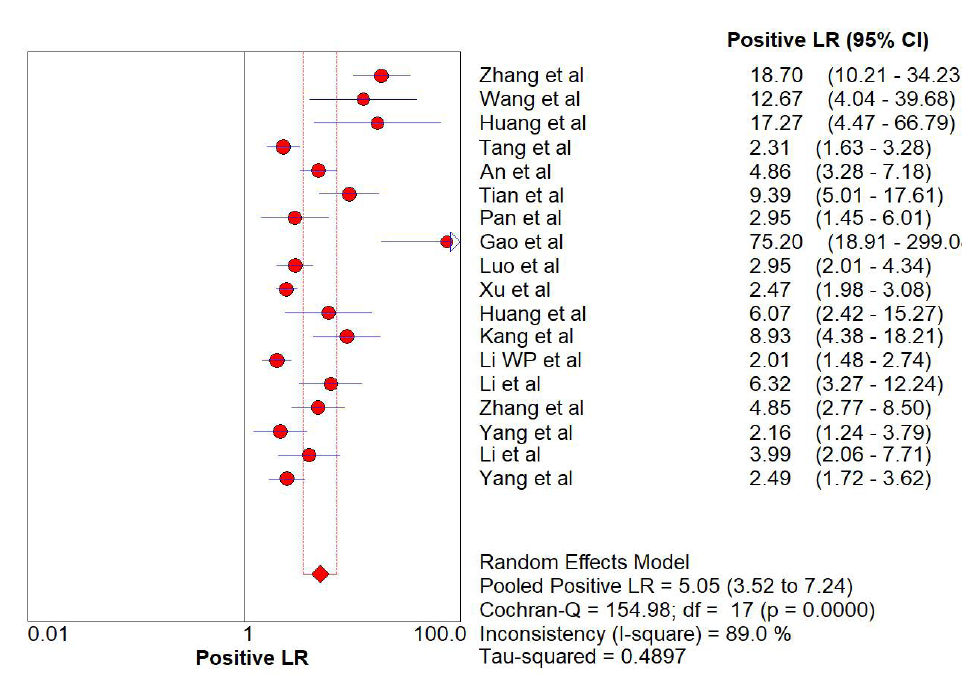
Figure 4: The forest plot of diagnostic +LR for serum Hcy in diagnosis of DN.